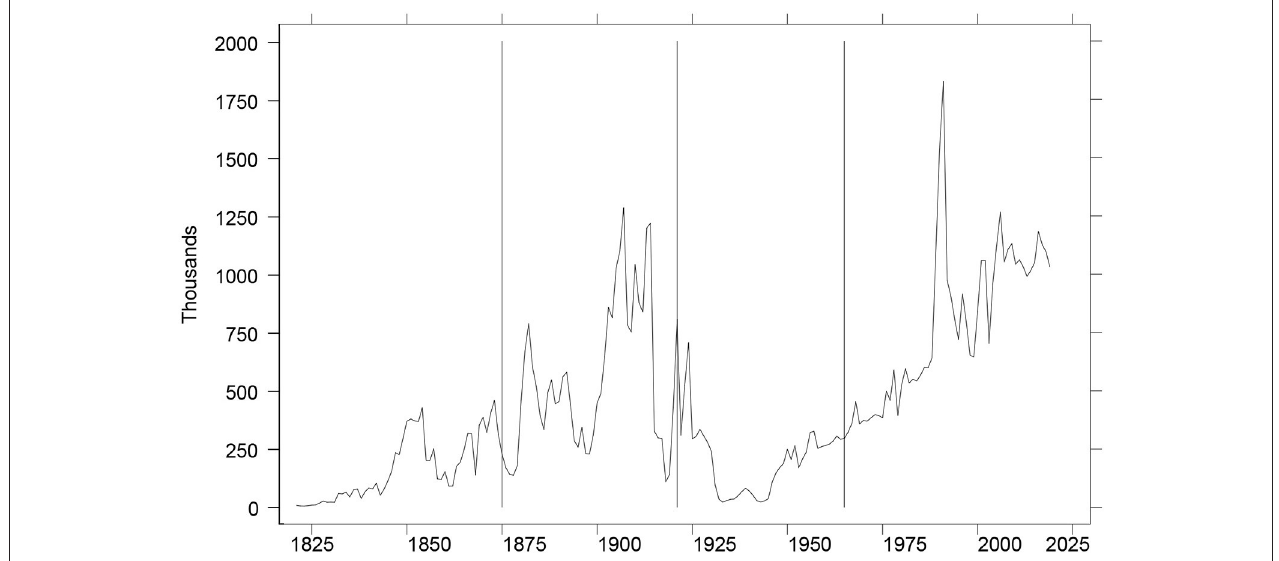
FIGURE 2 | Immigration to the United States: Four Immigration Eras, 1820-2019. Vertical lines at 1875, 1921, and 1965, marking the start of the Second through Fourth Immigration Eras.